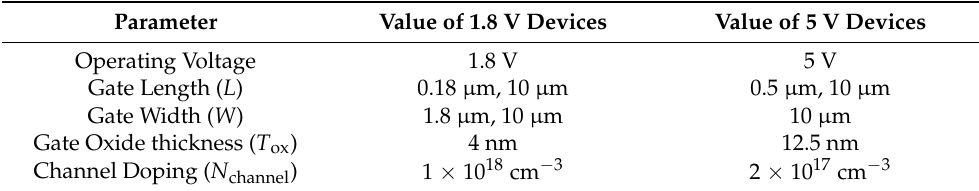
Table 1. Main parameters of the SOI-NMOSFETS under